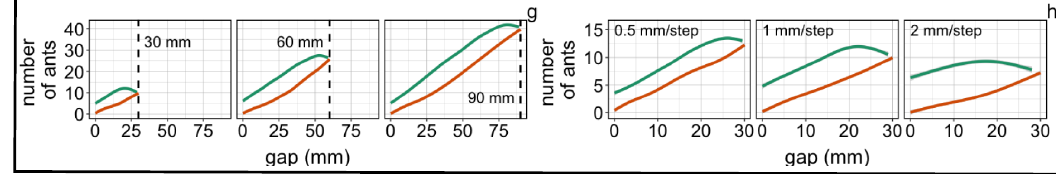
Fig. 4 Model comparison. The nonlinear accumulator model reproduces hysteretic dynamics of real bridges much more accurately than either linear model, avoids constant adjustments to momentary shifts, and performs well across a range of scales and rates of gap size changes. a – c Results of 10,000 simulations for the baseline model, delay model with three-step delay (1.5 min), and accumulator model, respectively. Thick lines indicate means across the simulations (expansion: dashed orange line, contraction: green solid line). Shading indicates the number of simulations occupying a cell (combination of gap size and the number of ants in either expansion or contraction in orange and green, respectively). Thin lines show 50 example simulations. Inset panels also show example simulations. The nonlinear accumulator model reproduces dynamics of real bridges much more accurately than either linear model. d – f Results of 1000 simulations for each model under the “ vibration ” conditions. Thick lines show means across simulations, thin lines show 50 example simulations. g , h Results of accumulator model scalability and sensitivity analyses, respectively. Lines show means across 100 simulations for each panel in which either the maximum gap size ( g ) or rate of gap size change ( h ) varied from the original experiment as